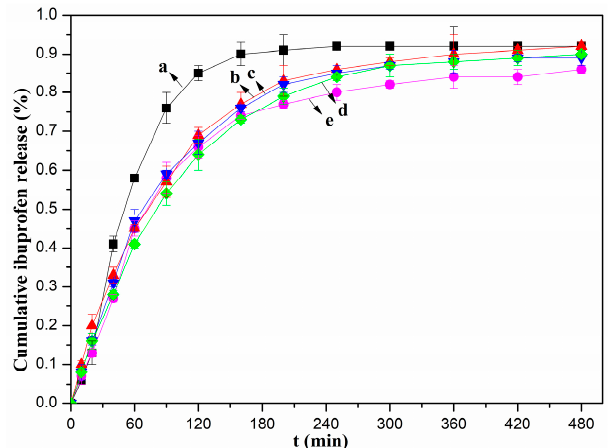
Figure 9. Release of ibuprofen from ( a ) SA, ( b ) HAD, ( c ) OAD, ( d ) DAD, and ( e ) LAD microcapsules (error bars represent the standard deviation of three replicates).